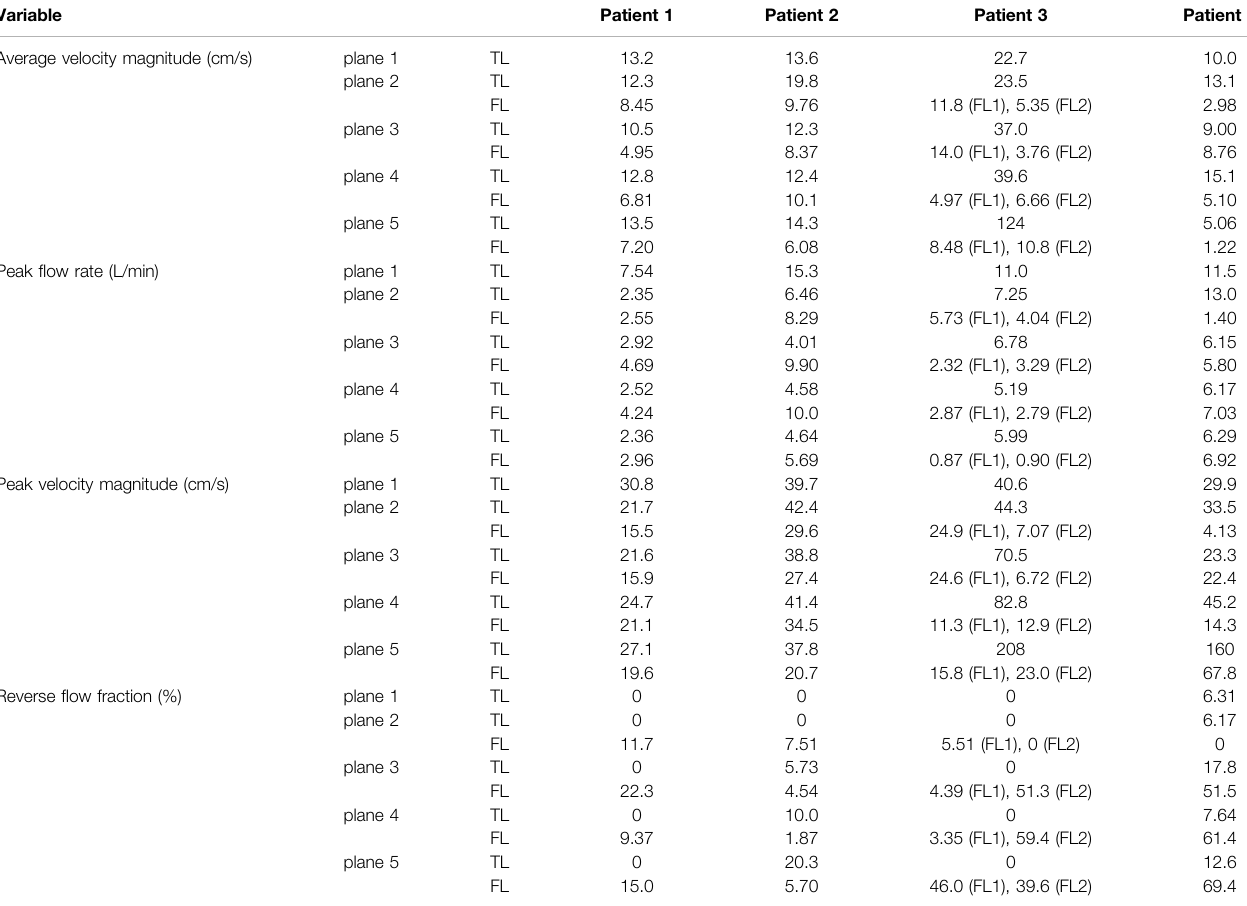
TABLE 2 | Blood fl ow measurements computed from 4D fl ow on the selected cross-sectional planes for the four patients. Variable Patient 1 Patient 2 Patient 3 Average velocity magnitude